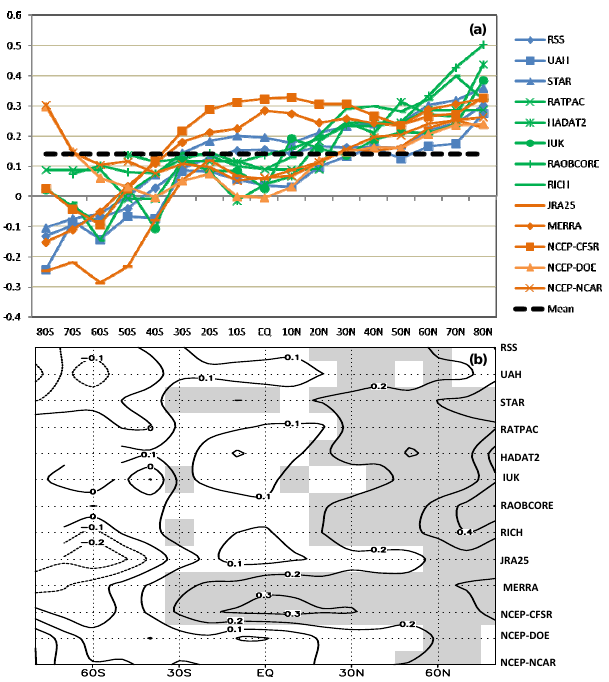
Fig. 3. Similar to the Fig. 1 except for the tropospheric temperature Fig. 3 Similar to the Fig. 1 except for the TroposphericTemperature (T CH2 ) Trends. The shaded areas in ( T CH2 ) trends. (b) The shaded areas indicated the statistical significance t ‐ test at the 99%